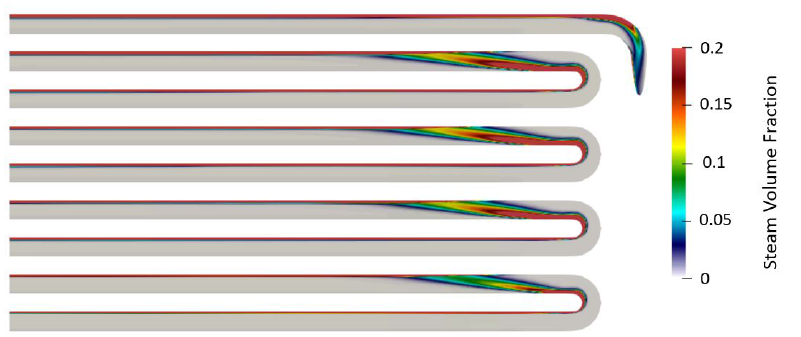
Figure 28. Gas volume fraction distribution through First Tubes in the convection section.